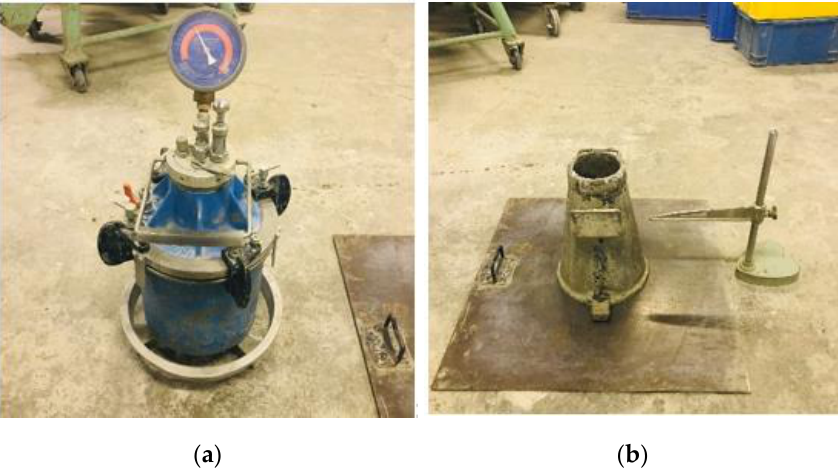
Figure 3. Devices used in the measurement of fresh concrete for the specimens. ( a ) Concrete air meter; ( b ) Slump